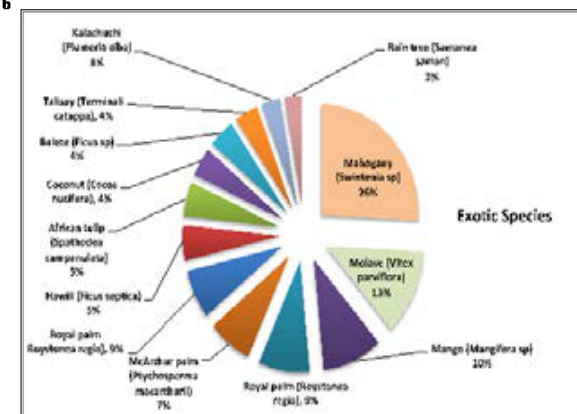
Figure 7. (b) Exotic species inventoried, Districts 1 and 5, Manila City,